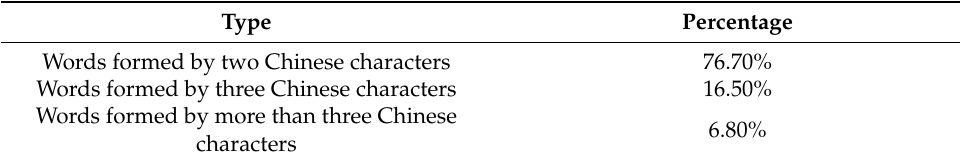
Table 3. Percentage of three types of words in the dictionary.